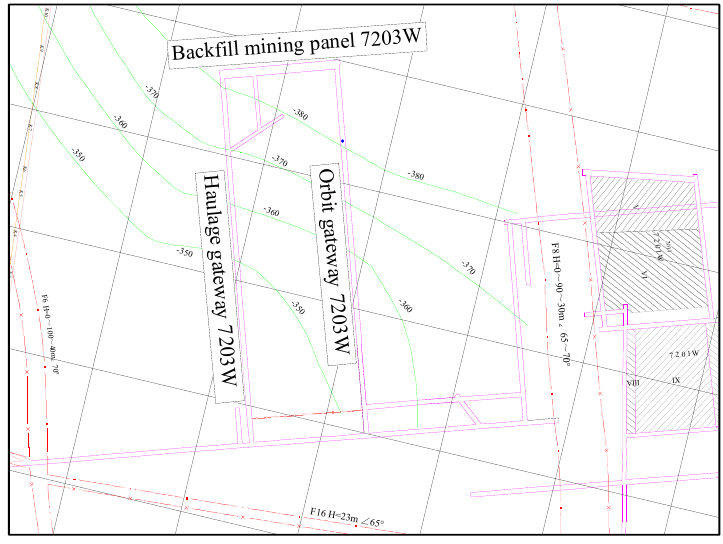
Figure 14. Schematic diagram of the 7203W solid backfill mining panel.